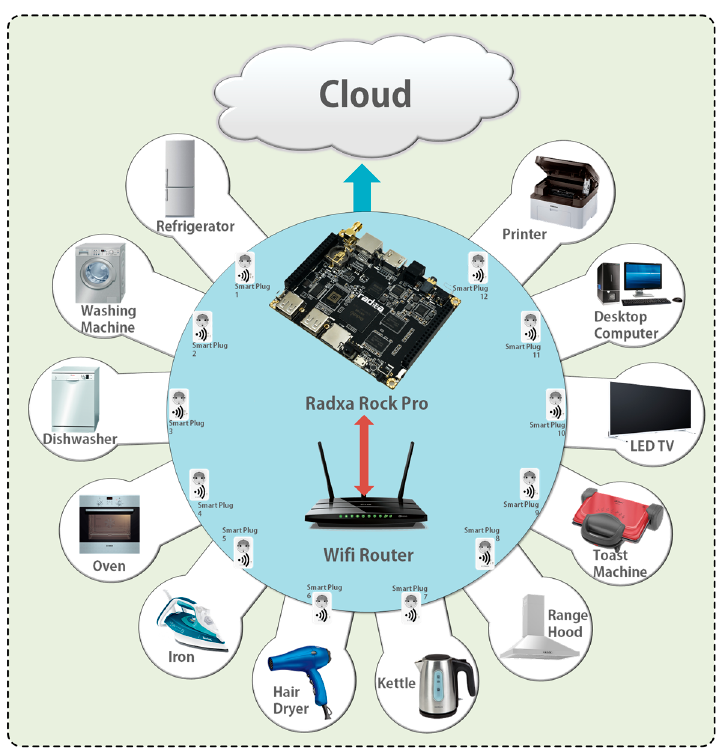
Figure 1. The block diagram of the implemented system.